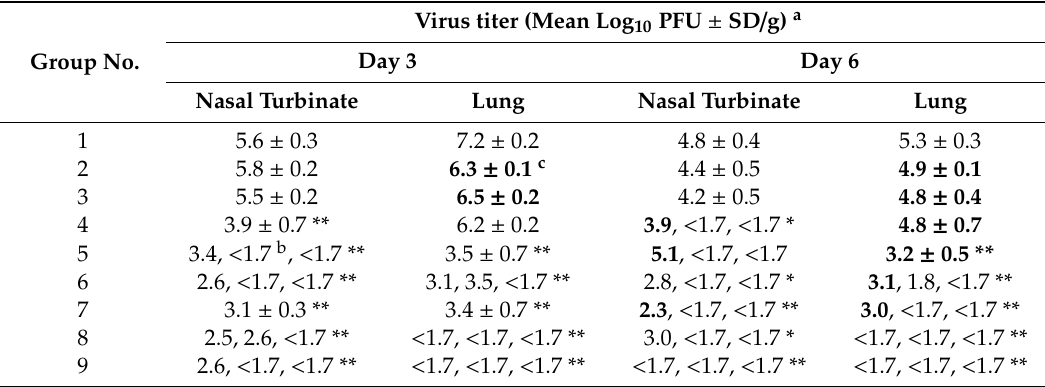
Table 2. Lung virus titers of infected mice treated with the inhibitors.